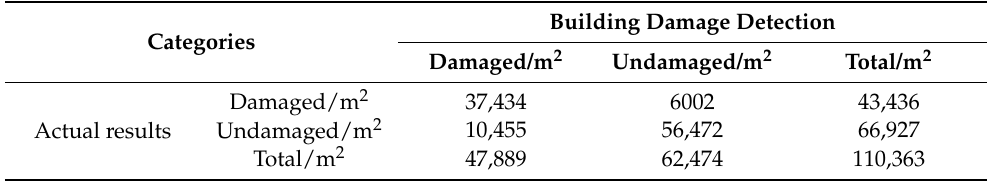
Table 4. Accuracy verification of building damage detection.